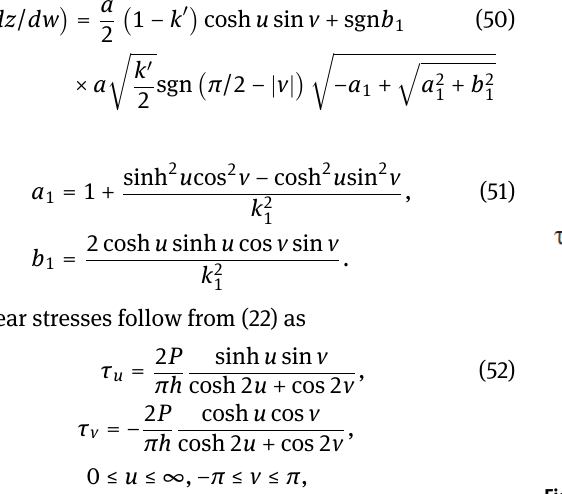
Figure 6: Shear stress for the slot in the u-direction